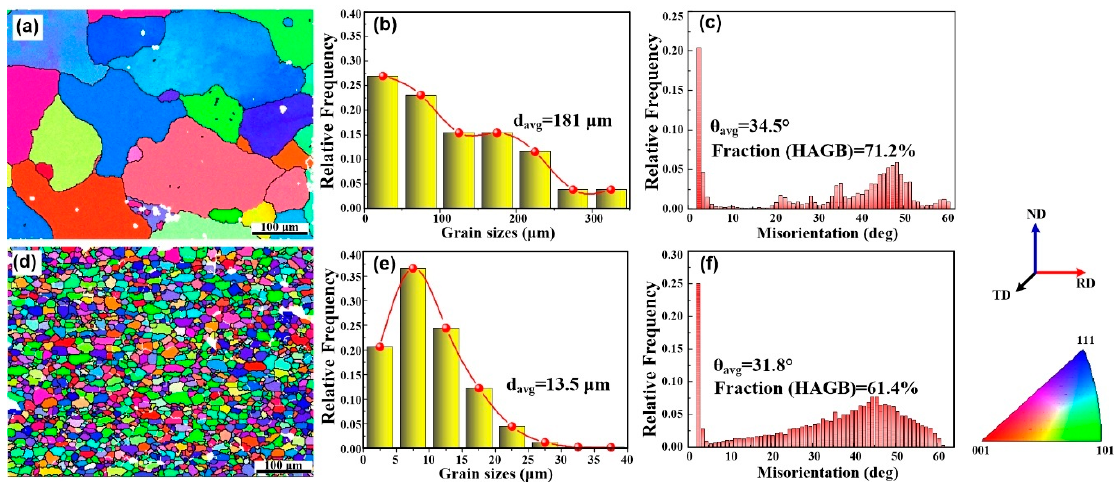
Figure 4. ( a ) and ( d ) inverse pole figure (IPF) maps, ( b ) and ( e ) the distribution of grain sizes, ( c ) and ( f ) misorientation distribution for AA2219 alloy and 5 wt.% nanosized TiB 2 /AA2219 composite.